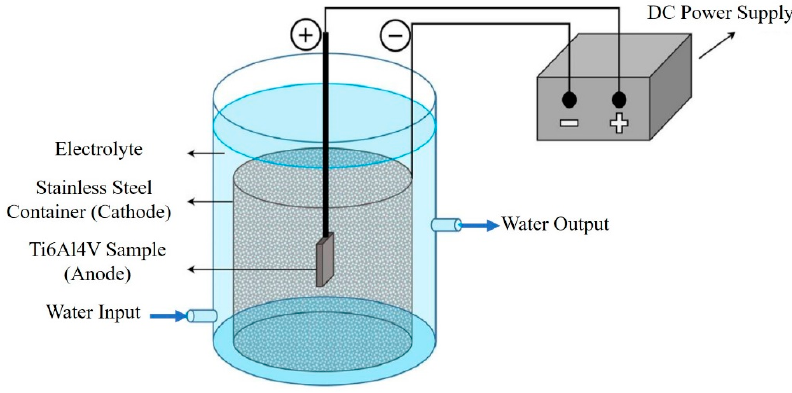
Figure 1. Schematic representation of the installation for PEO processing.